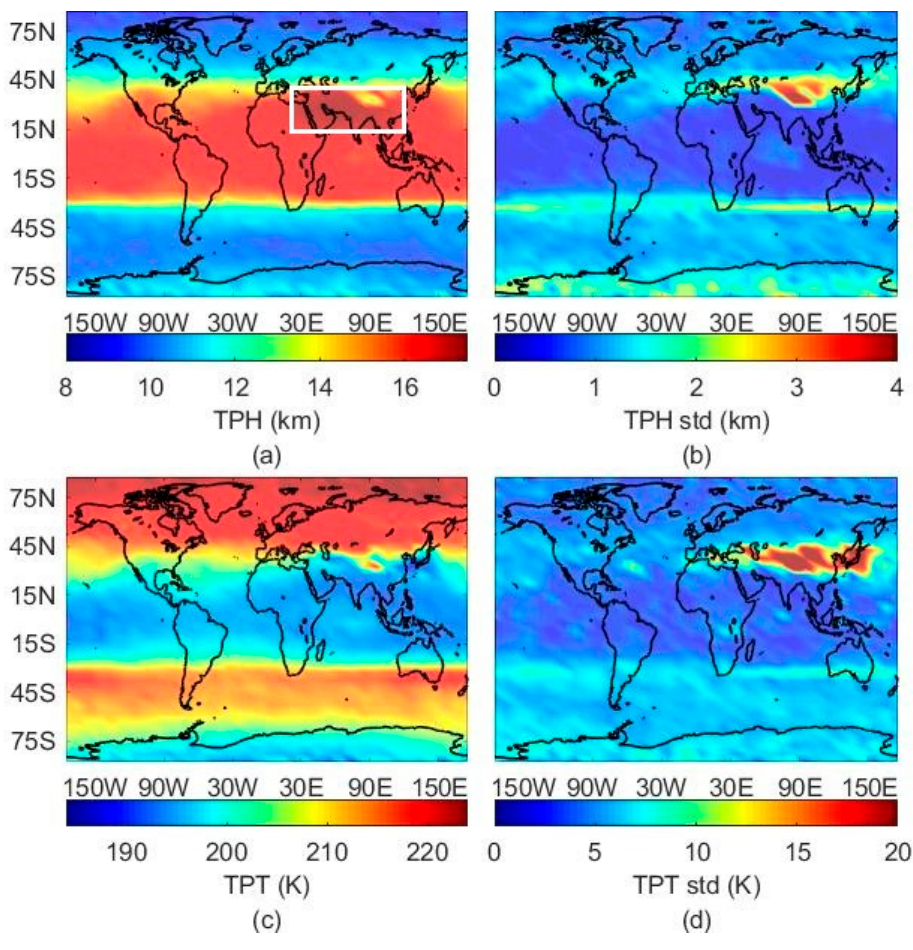
Figure 10. Seasonal patterns (a–d) of TPT and TPH for summer (June, July, August). White box points out the region where the tropopause is extremely high.